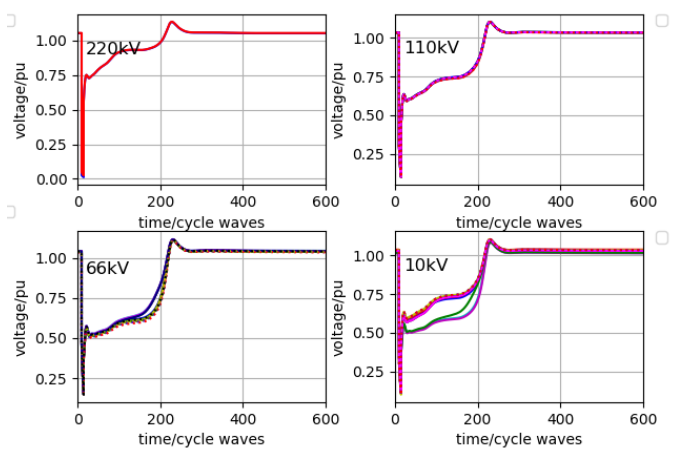
Figure 14. Fault 1 Action 673: Bus positive sequence voltages after SVG compensates 50 Mvar, 70 Mvar, 60 Mvar, 50 Mvar and 50 Mvar, respectively.